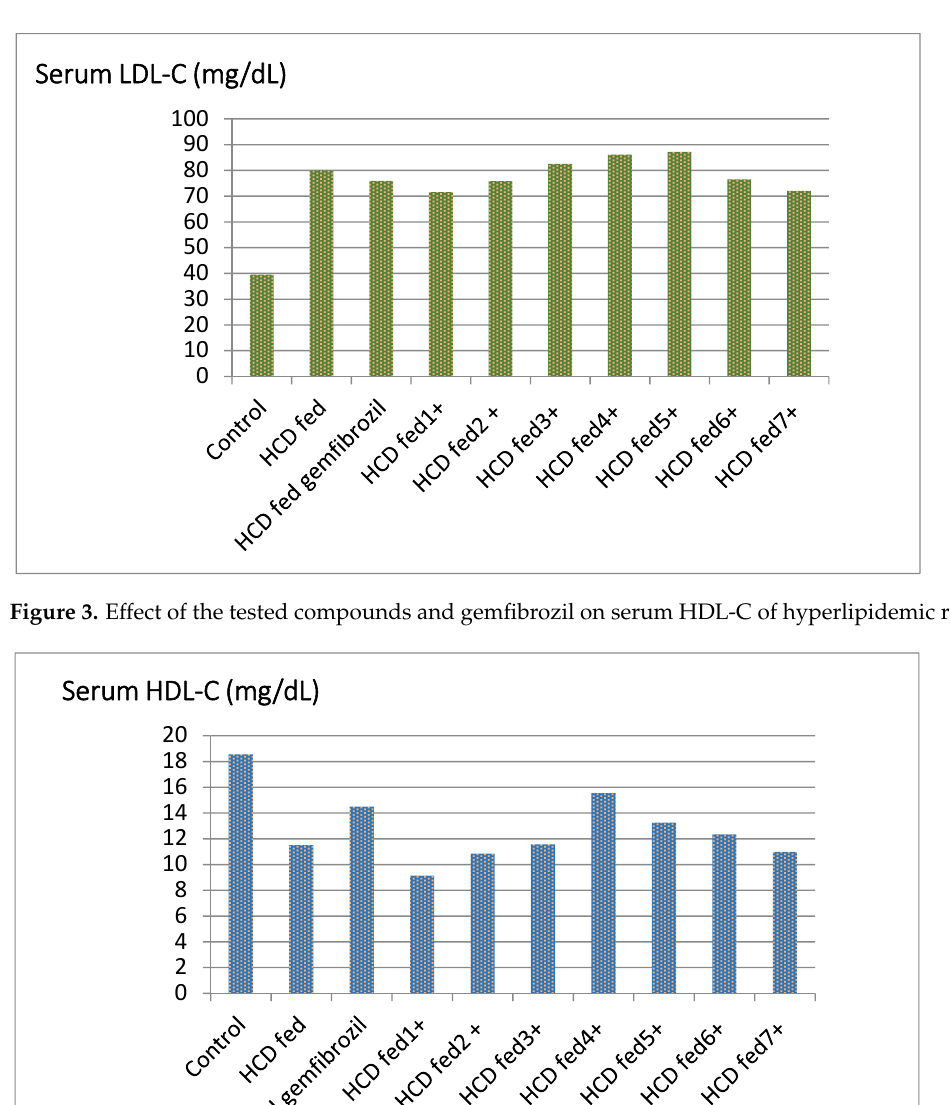
Figure 2. Effect of the tested compounds and gemfibrozil on serum TG of hyperlipidemic rats.